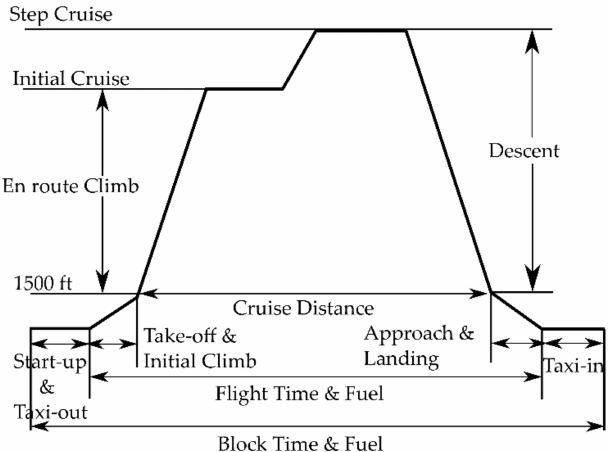
Figure 5. Mission profile as defined by Association of European Airliners [85].